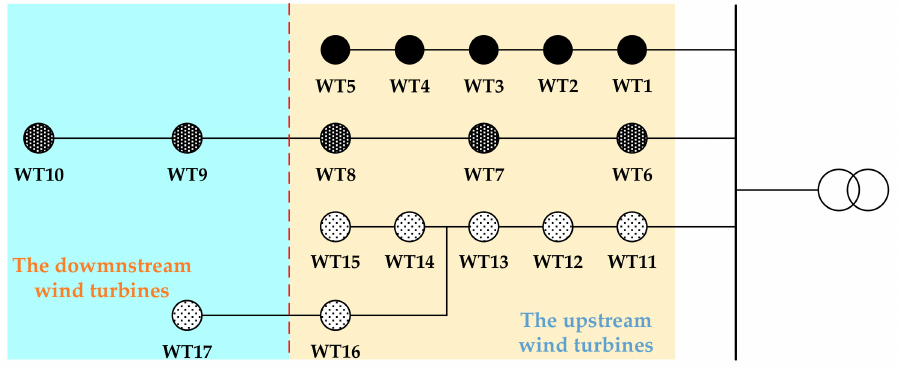
Figure 10. Division of wind turbines.